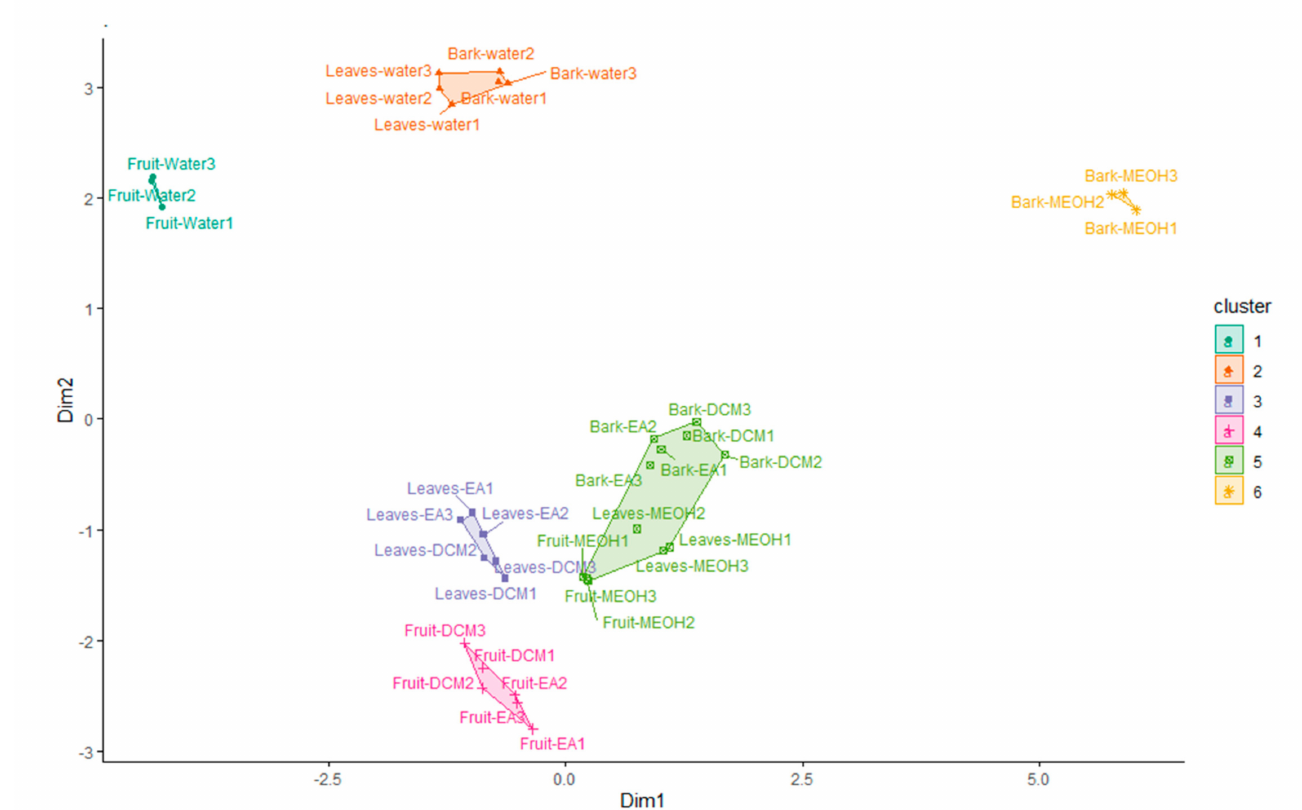
Figure 9. Cluster map of unsupervised hierarchical clustered analysis (similarity: Euclidean, linkage rule: